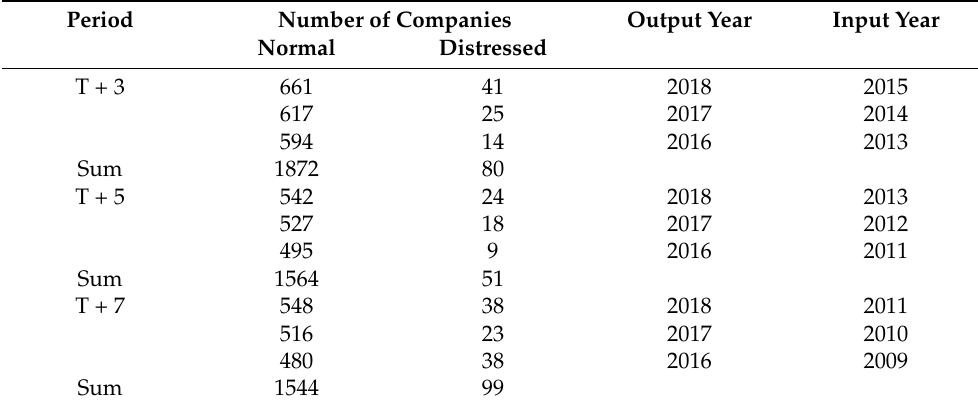
Table 2. Number of Data for Each Prediction